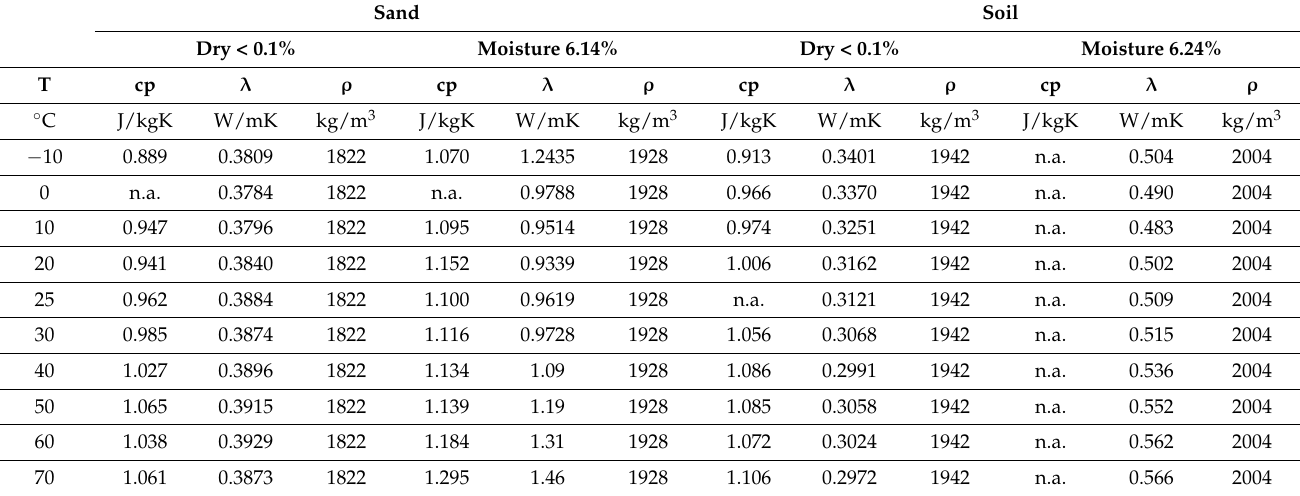
Table 4. Material